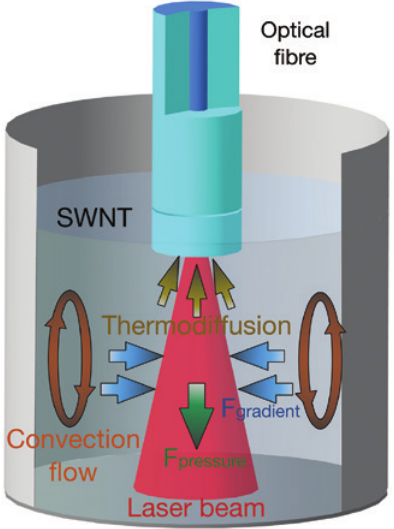
Figure 13: Theoretical explanation of CNT optical deposition process on fibre